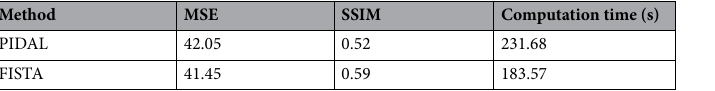
Table 1. Comparison of MSE, SSIM, and computation time using FISTA and PIDAL. The computation time was measured on an Intel Core i9-7920X CPU.